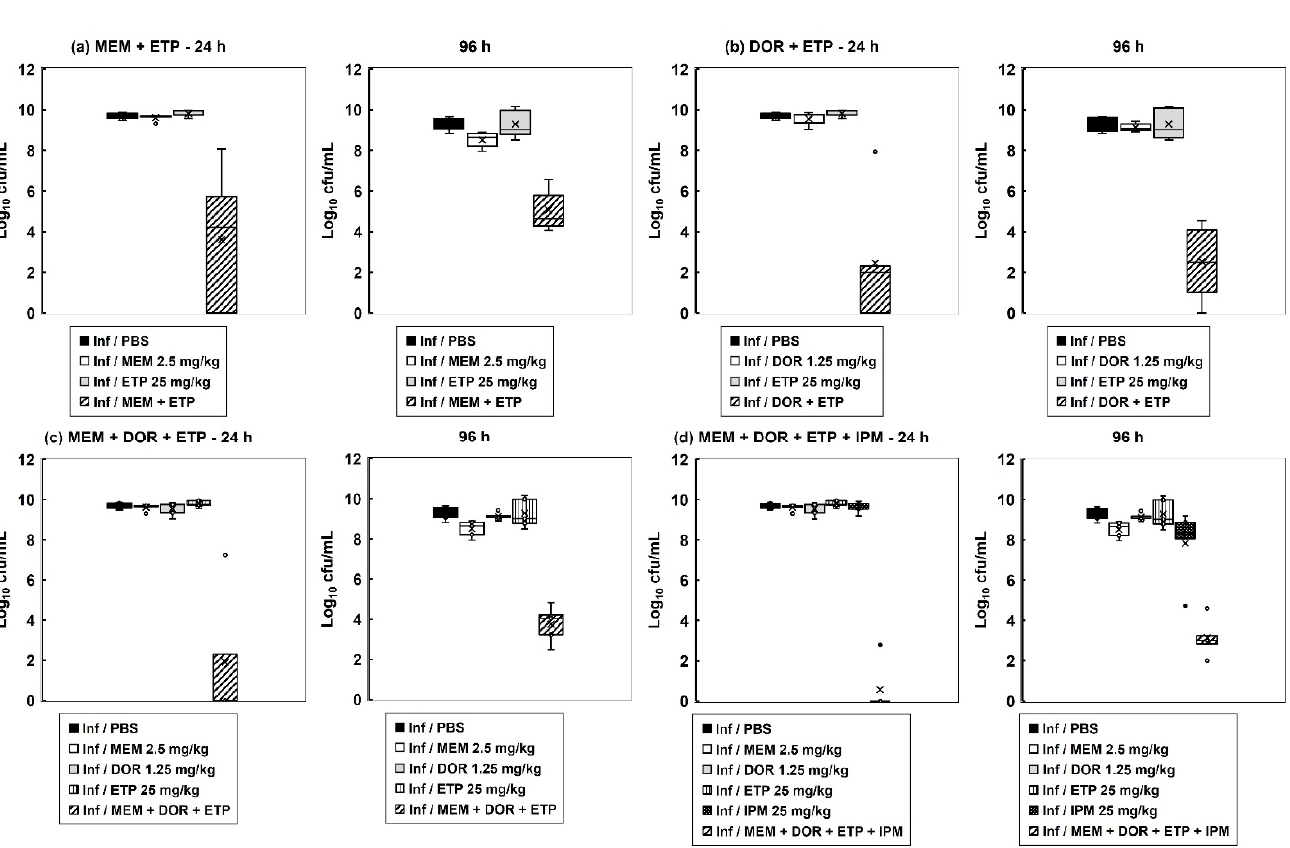
Figure 3. The effect of carbapenem monotherapies and dual, triple, and quadruple carbapenem combinations on the internal burden of P. aeruginosa NCTC13437 in G. mellonella larvae. Larvae were infected with 2.5 × 10 3 cfu/mL of P. aeruginosa NCTC13437 and treated with either PBS (mock ‘treated’), or a single dose of each carbapenem, or a combination of: ( a ) MEM (2.5 mg/kg) + ETP (25 mg/kg); ( b ) DOR (1.25 mg/kg) + ETP (25 mg/kg); (c) MEM (2.5 mg/kg) + DOR (1.25 mg/kg) + ETP (25 mg/kg); ( d ) MEM (2.5 mg/kg) + DOR (1.25 mg/kg) + ETP (25 mg/kg) + IPM (25 mg/kg) at 2 h p.i. Larvae were incubated at 37 °C, and the internal burden of P. aeruginosa was determined from five individual larvae per treatment group after 24 and 96 h at 37 °C. The ‘×’ indicates the mean, the bar indicates the median and the error bars show the highest and lowest values within the dataset. Outlier data is shown as independent points. Each combination treatment showed a significant reduction in bacterial burden compared with each monotherapy ( p < 0.05, the Mann–Whitney U -test; n = 5).